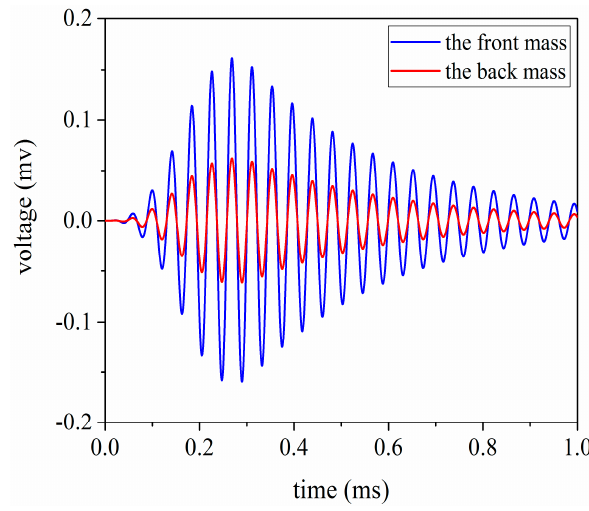
Figure 13. The vibrational velocity ratio between the front and back masses.